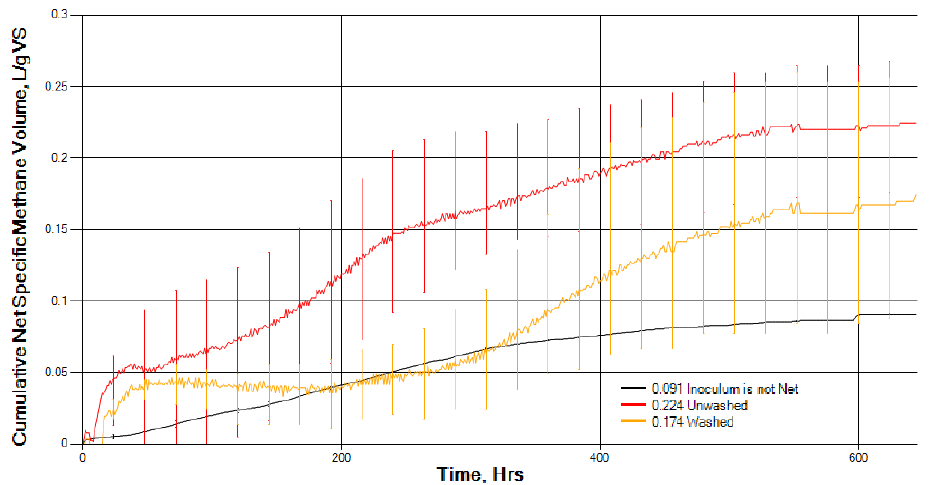
Figure 4 . Net cumulative biomethane yield for unwashed and washed S. muticum (error bars = maximum and minimum readings n = 3).